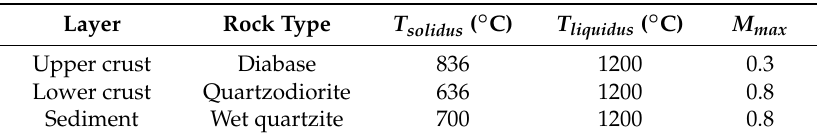
Table 5. Melting points of different lithospheric layers (According to metamorphic modelling with Perple-x by Ganne et al. [4]). Layer Rock Type T solidus ( ◦ C) T liquidus ( ◦